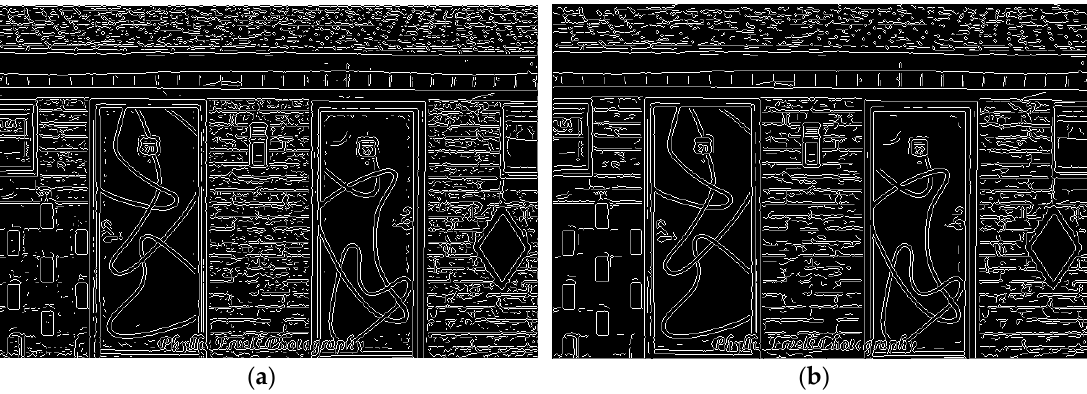
Figure 12. Comparison of edge images obtained by optimal edge thinning and edge texture construction. ( a ) Edge image with optimal edge thinning; ( b ) edge image after edge texture construction.